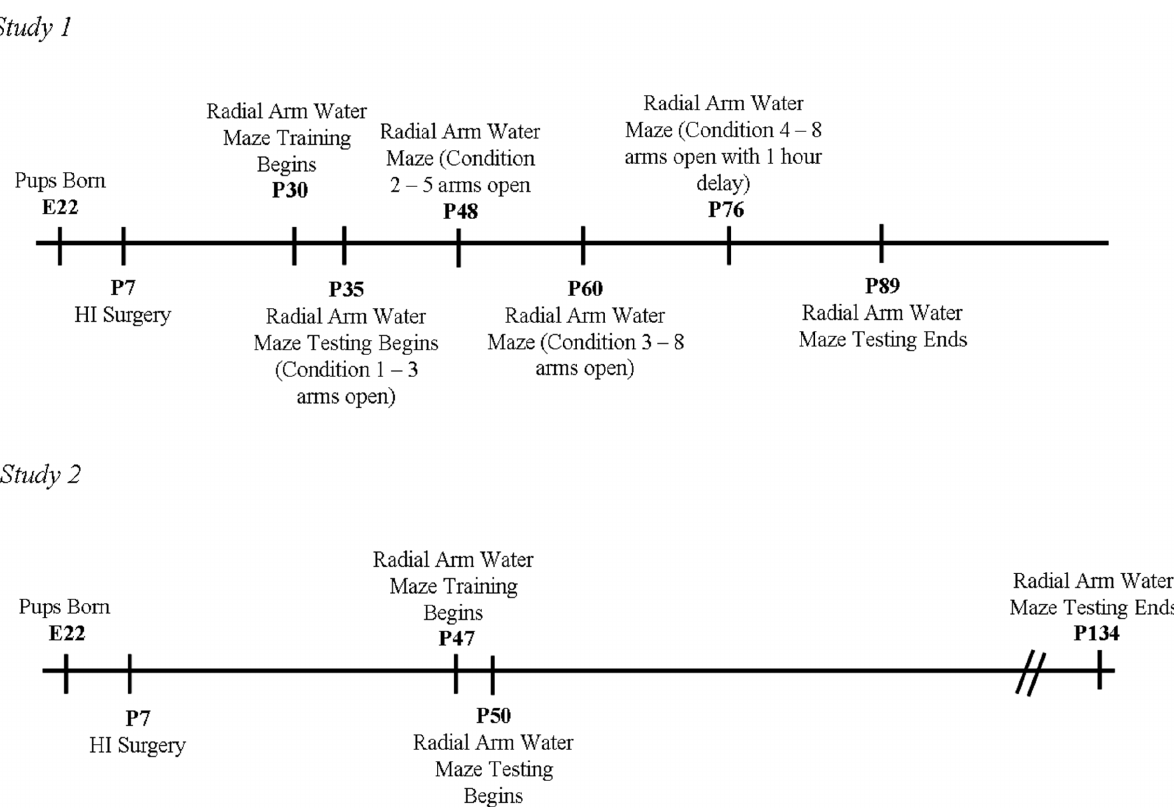
Figure 1. Study 1 and Study 2